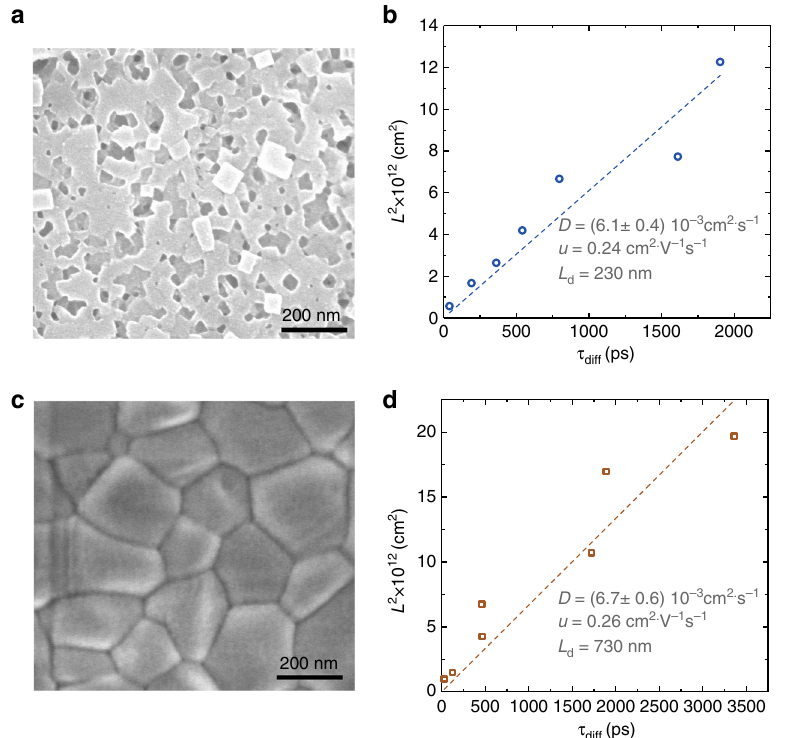
Fig. 5 3D diffusion-quenching measurement on perovskite thin fi lms. a SEM image of MAPbBr 0.17 I 0.83 perovskite thin fi lm synthesized using 2-step method. b Fitting of diffusion coef fi cient and carrier mobility of MAPbBr 0.17 I 0.83 perovskite thin fi lms. c SEM image of perovskite thin fi lm with mixed cations and anions (Cs 0.05 MA 0.14 FA 0.81 PbI 2.55 Br 0.45 ) synthesized using 1-step method and d fi tting of coef fi cient and carrier mobility accordingly